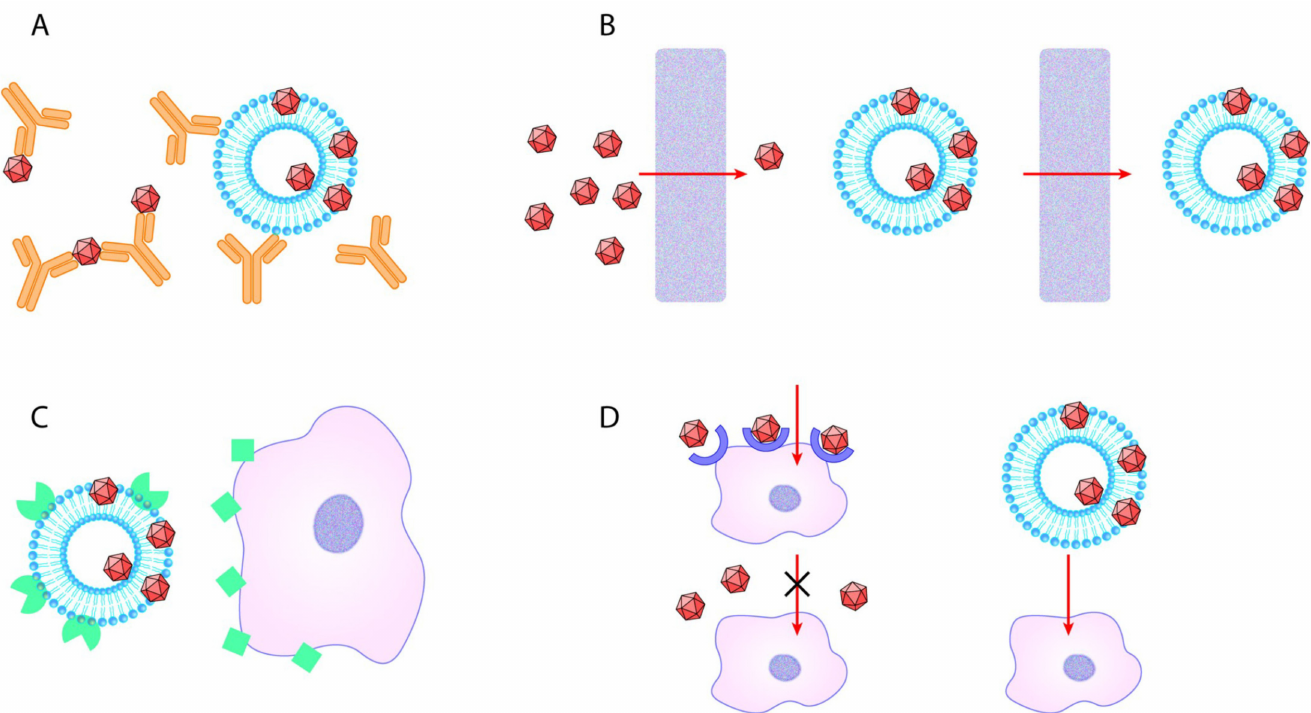
Figure 4. Potential advantages of EV-AAV over standard AAV. ( A ) EV-AAV can shield AAV capsids from humoral immune response. ( B ) EV-AAV may traverse in vivo biological barriers, while transferring AAV either attached to them or inside of them more effectively compared to standard AAV. ( C ) By producing EV with targeting proteins of their surface, gene transfer may be easily carried out. ( D ) AAV particles are not taken up by cells, which do not express AAV-receptors. However, vesicles may enter cells through multiple receptors, thus making previously non-susceptible cells to be able to uptake AAV transferred by